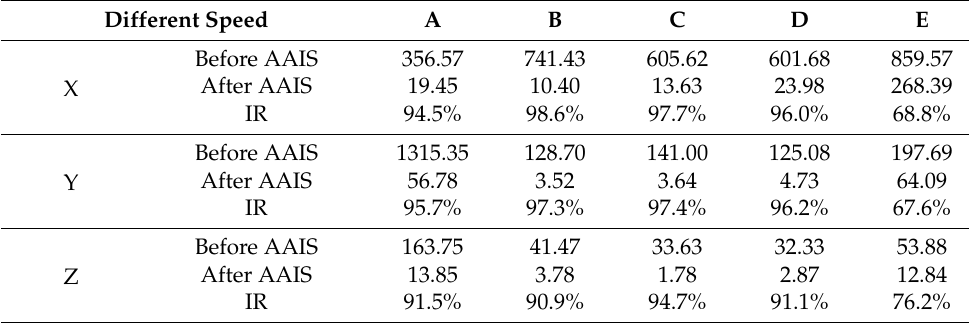
Table 9. The standard deviation (nT) at different rotation